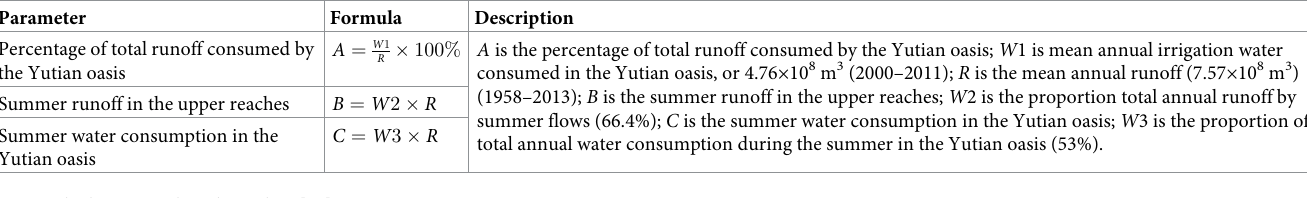
Table 5. Calculation and description of upper reach runoff and water use in the Yutian